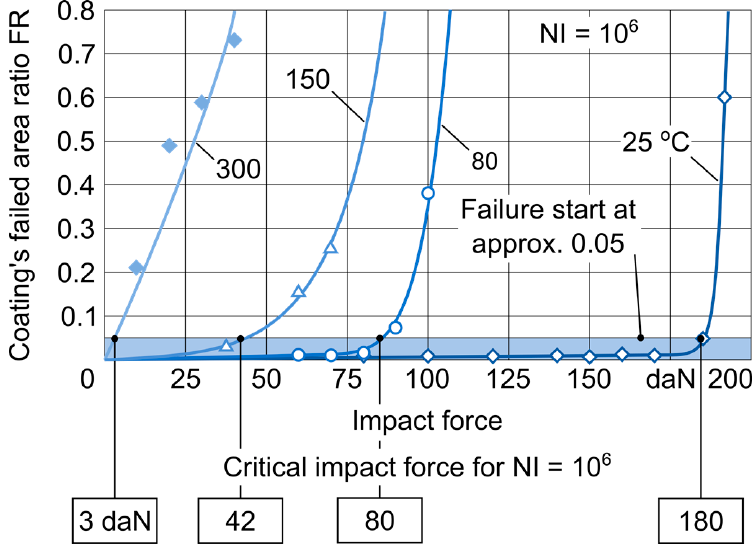
Figure 13. FR of the DLC coating after 10 6 impacts at various temperatures and impact forces. A significant reduction of the critical impact force develops, when the test temperature increases ◦ ◦ stepwise from 25 up to 300 C, as shown in Figure 14. At the temperature of 300 C, the DLC coating fails after 10 6 impacts, at impact forces of only 3 daN. After the coating failure initiation, the coating removal rate from the substrate surface is almost equally intensive in all tested temperature cases, as the curves of Figure 13